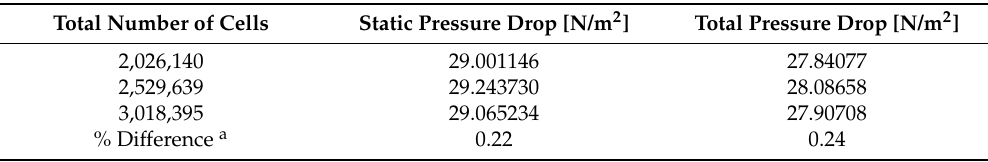
Table 5. The details of the grid independence study for the sensor box’s cavity. Total Number of